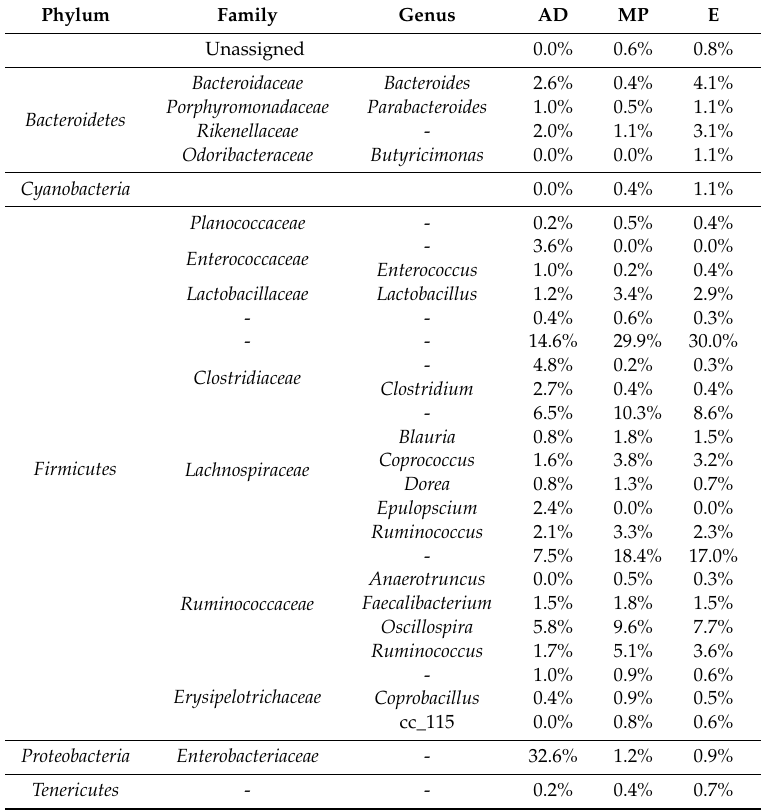
Table 6. Taxonomic profiles at genus level according to the sampling moment in slow-growing management